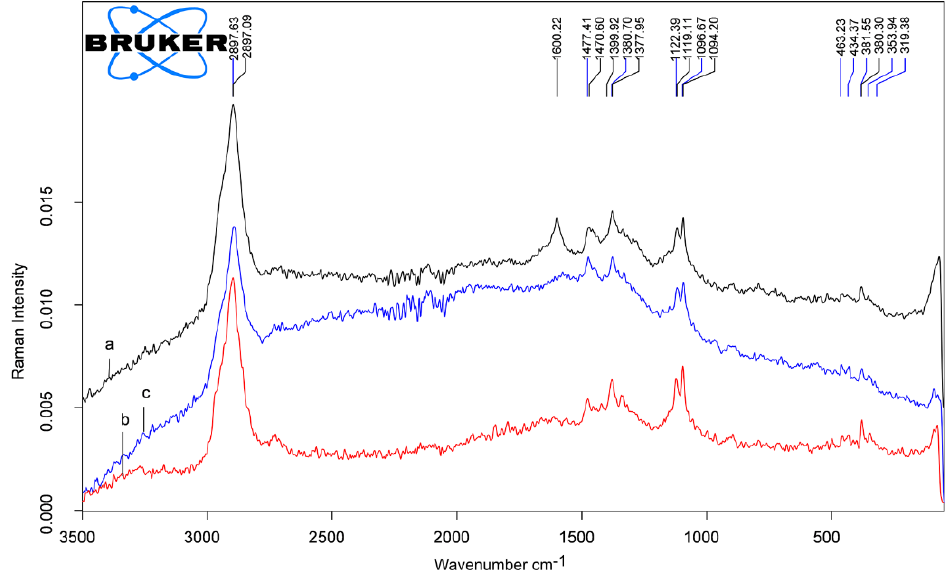
Figure 10. FT-Raman spectra for ink: ( a ) S1; ( b ) S2; ( c ) S3.